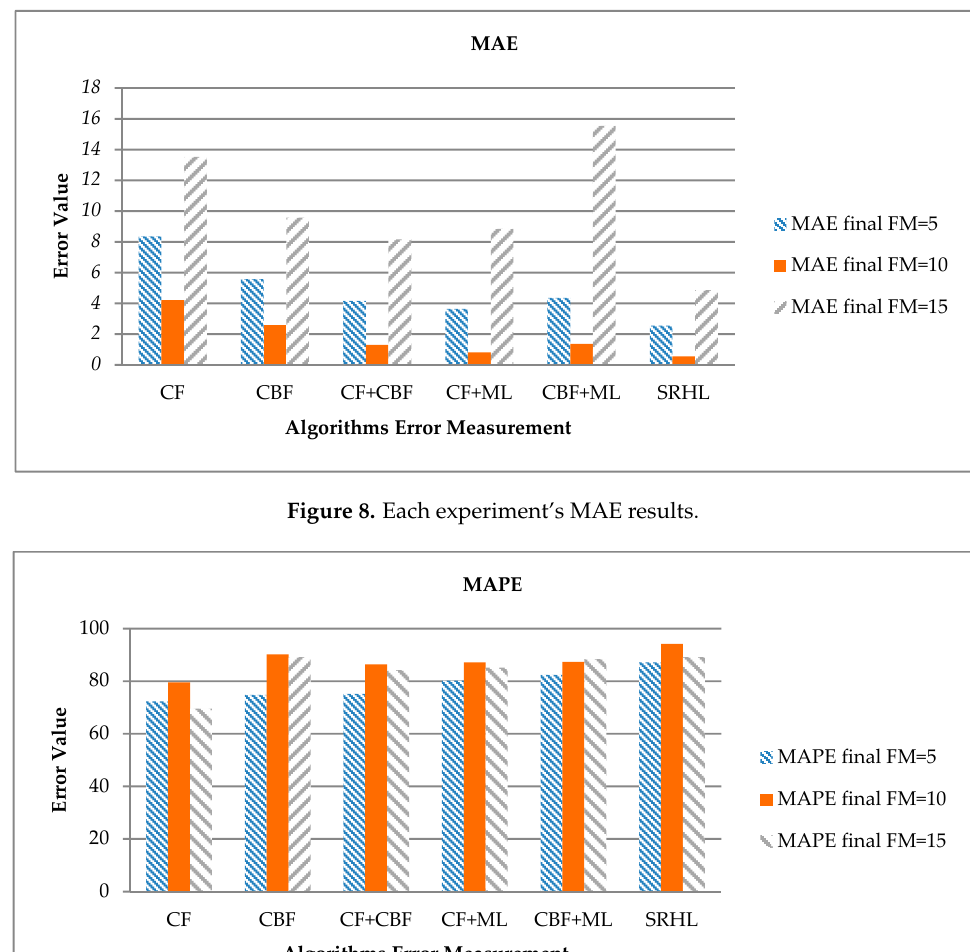
Figure 10. Each experiment’s MSE results . For the experiment we selected close to the FM dominant, this is explicitly and intrinsically, perhaps even directly, related to personal health. The prediction estimates were done among a set of three evaluation criteria matrix error models, explained in Table 6: mean absolute error (MAE), mean absolute percentage error (MAPE), and mean squared error (MSE ) . The experimental results indicate that the error correlation was compared with the proposed learning methods in SRHL. The experiment used a precollected dataset that included the user profile and history ratings assuming the user feedback after the algorithm was deployed was the same as in the precollected dataset; first FM size sequentially is 5, 10, 15. Table 6. Formulas of MAE, MAPE, and MSE evaluation criteria. Evaluation Criterion